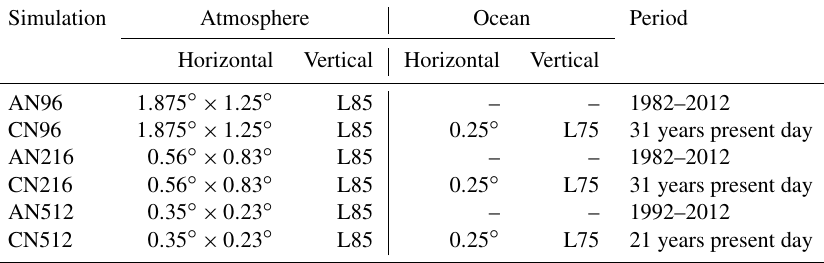
Table 1. Simulations used in this study. L85 of the atmospheric vertical resolution is a terrain-following hybrid height coordinate (units: m) that has 85 levels and a fixed model lid at 85km (Hewitt et al., 2011). L75 of the oceanic vertical resolution is a z ∗ coordinate (units: m) (Hewitt et al., 2011; Madec and Imbard, 1996).